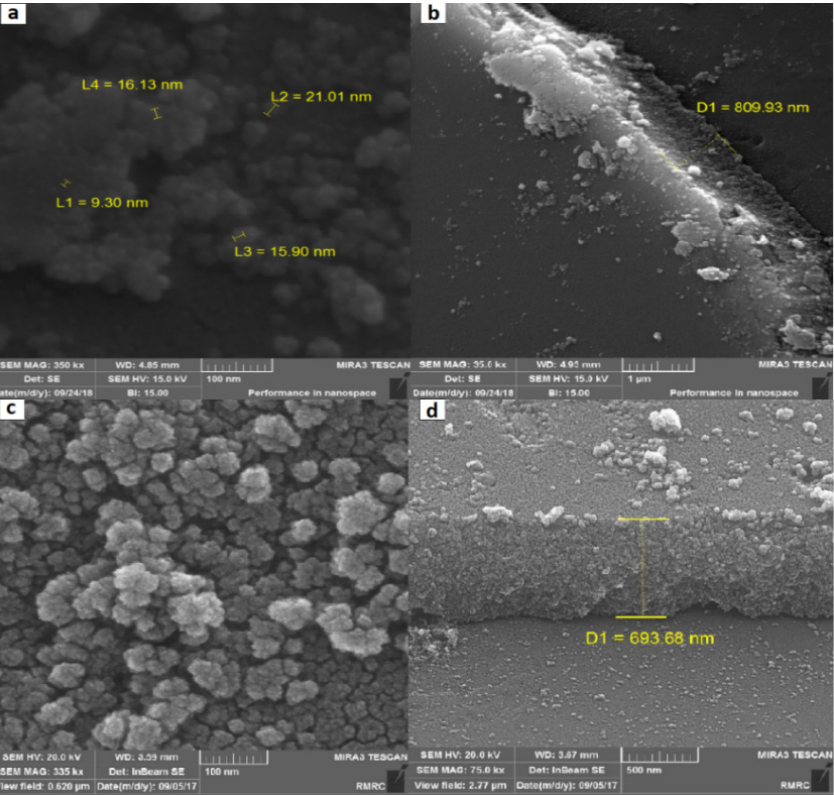
Figure 3 . SEM images of nanometer size of pure TiO (c) coating particles and thickness of TiO